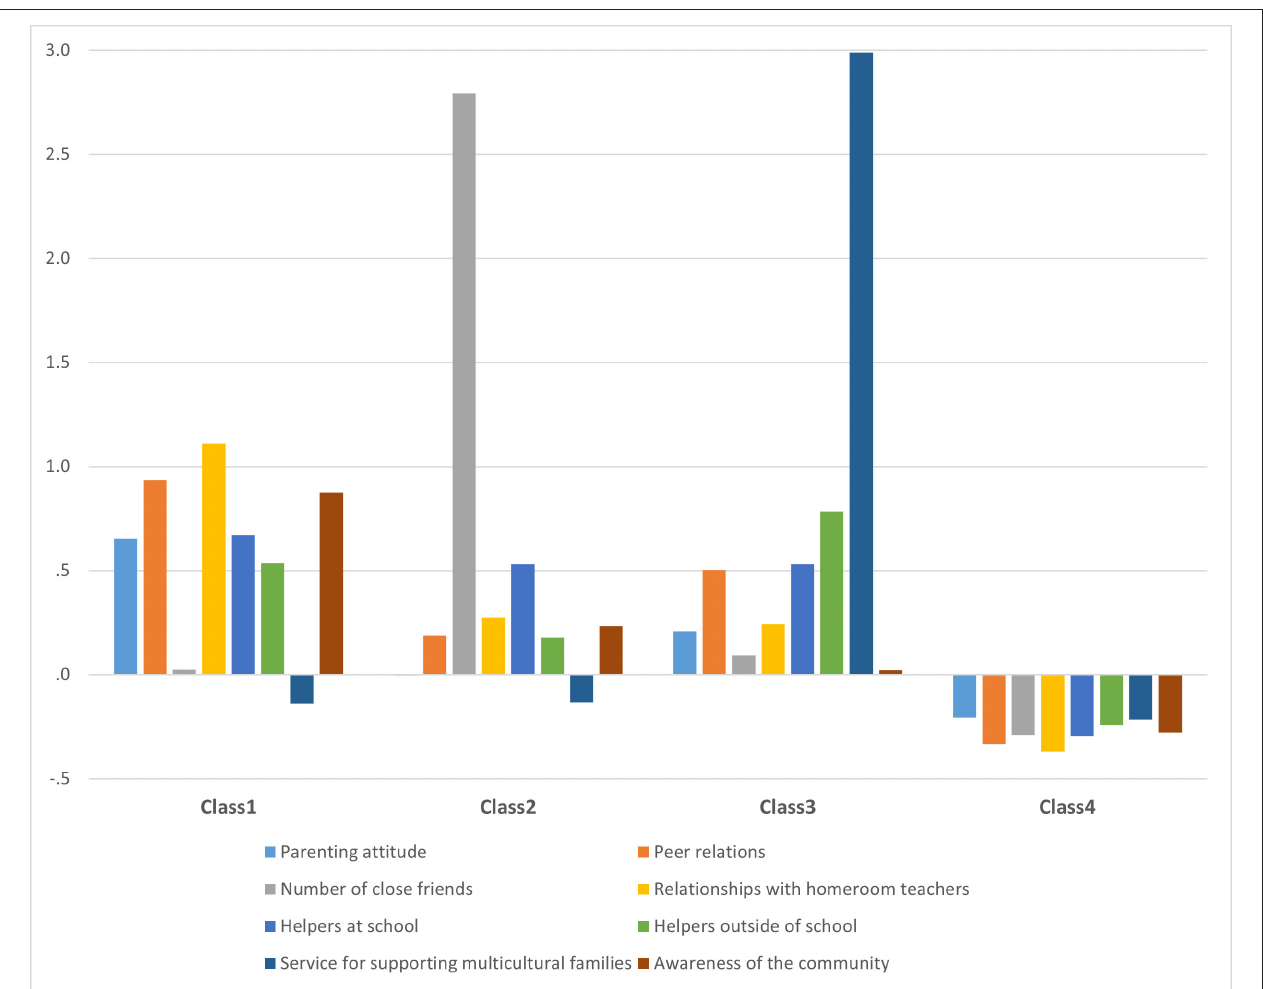
FIGURE 1 | Illustration of z-score distribution of social capital in the four profiles defined in the latent profile analysis.